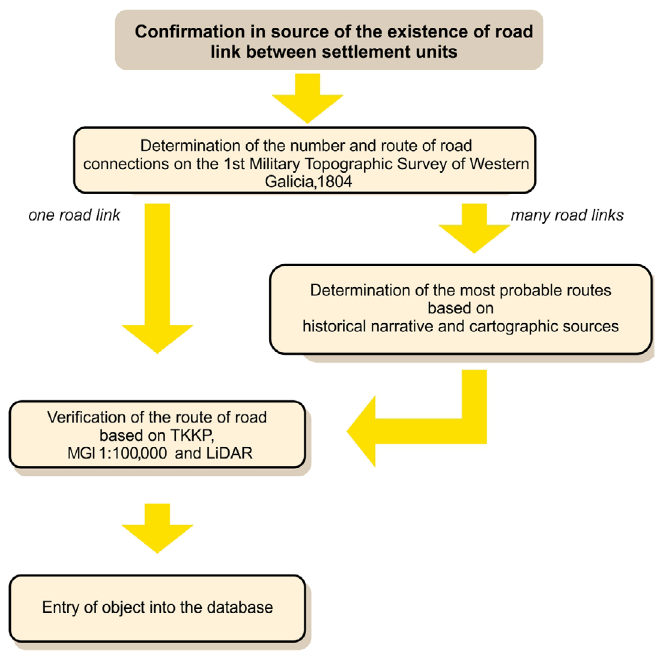
Fig. 7. Diagram of the process of reconstruction of the roads’ courses (author’s own